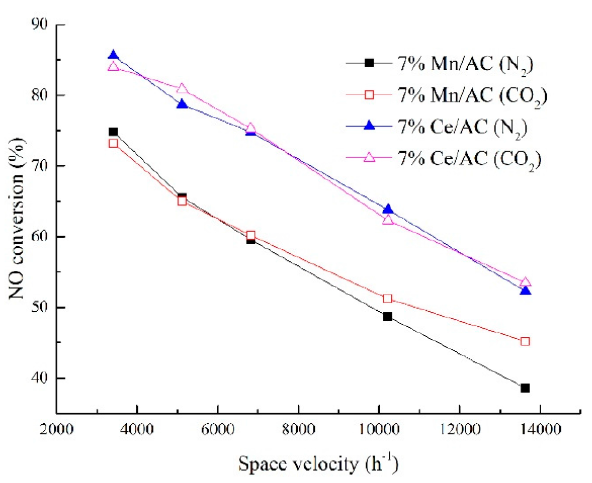
Figure 7. NH 3 -SCR using different space velocity under CO 2 and N 2 atmosphere. Other conditions: temperature 250 °C; 800 ppm NO; 800 ppm NH 3 and 6% O 2 .